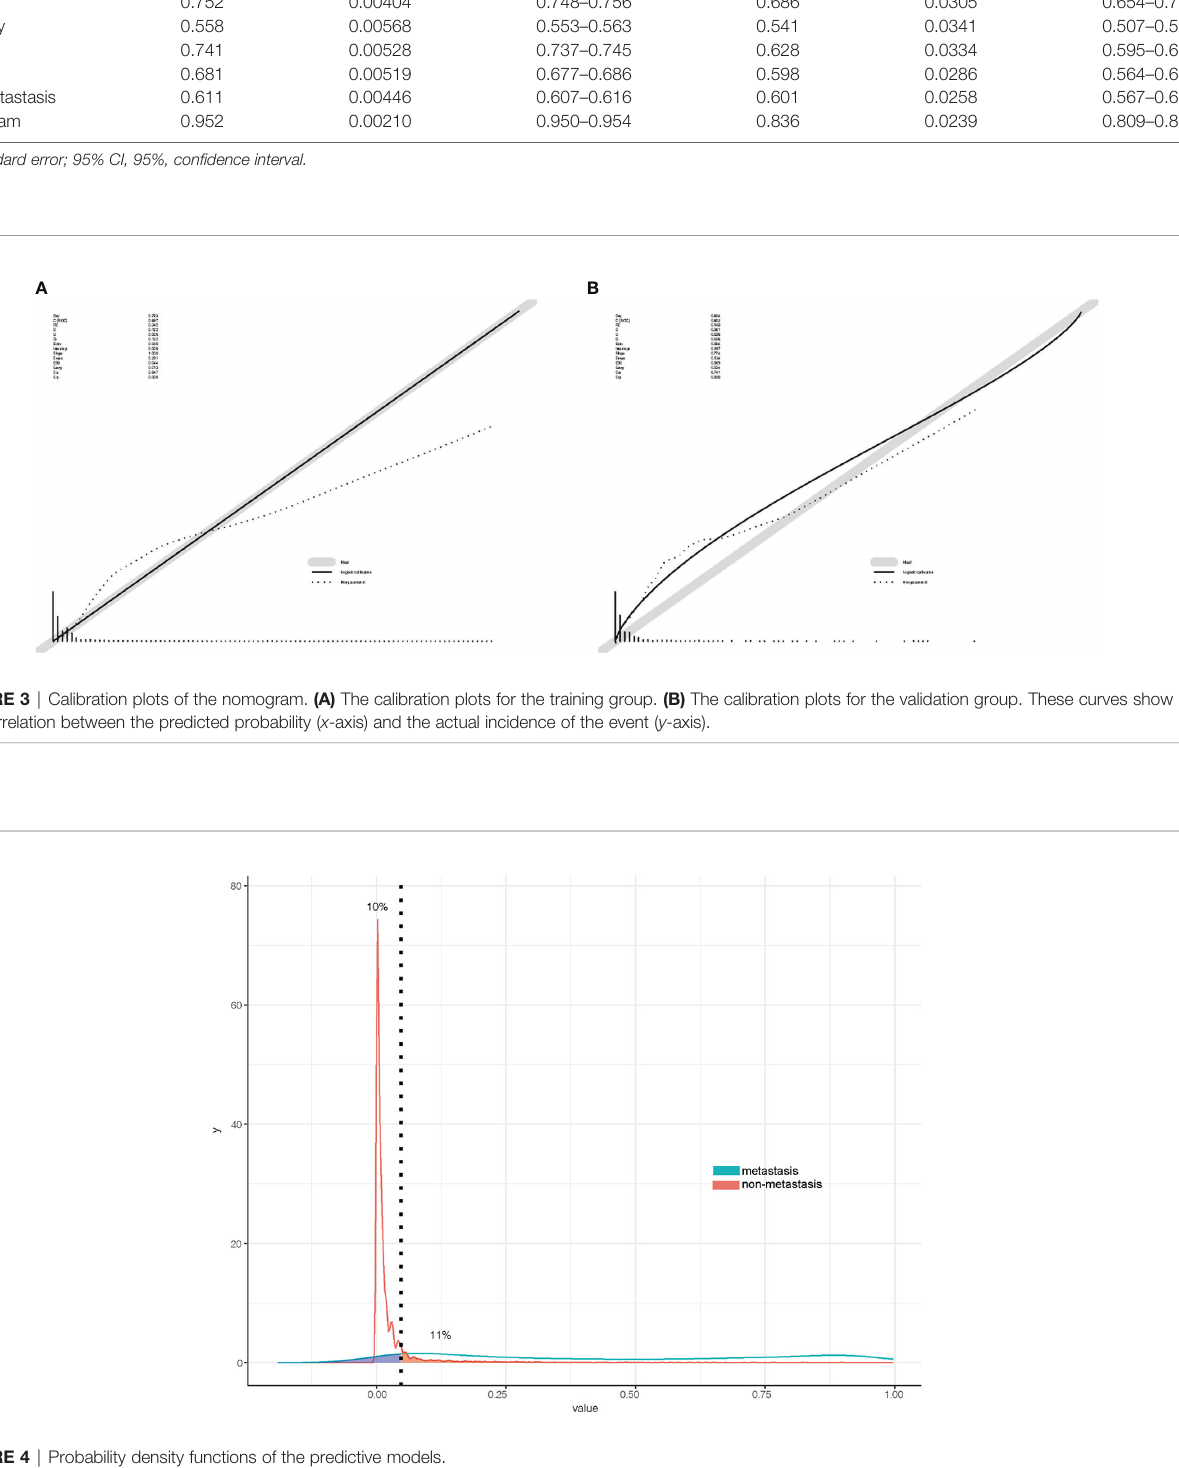
FIGURE 4 | Probability density functions of the predictive